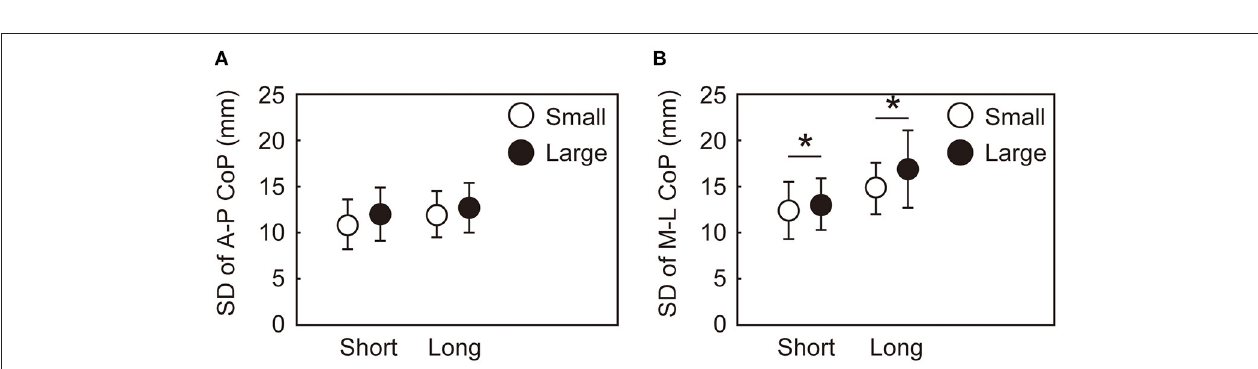
FIGURE 6 | Within-participant standard deviations of the maximum CoP displacement during the APA along the AP (A) and ML (B) axes. The error bars show the between-participant standard deviations of the within-participant variability. *Indicates a significant difference between the small and large target conditions ( p <